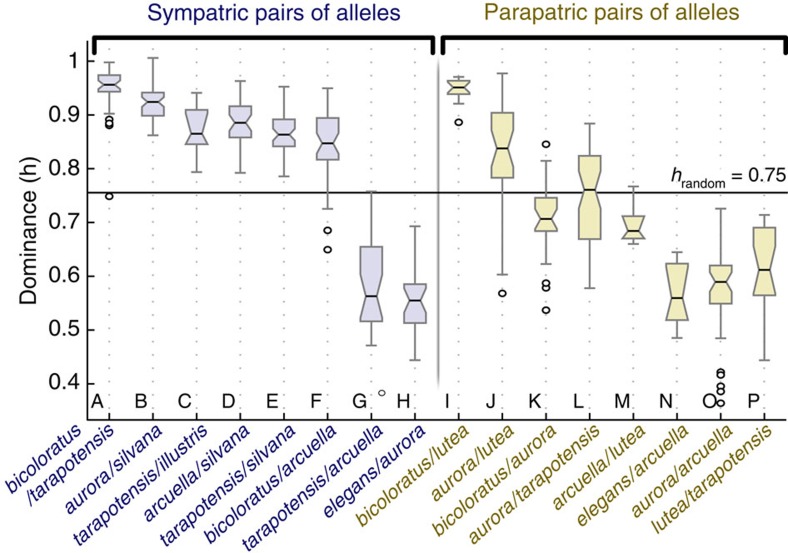
Variation of dominance between different pairs of supergene alleles.Box plot with the median, first, third interquartile range, extreme value and outliers represent the variation of dominance between pairs of alleles found in sympatry (blue) or parapatry (yellow). Dominance is measured in the direction of the most dominant allele (h=1: complete dominance; h=0.5: co-dominance).